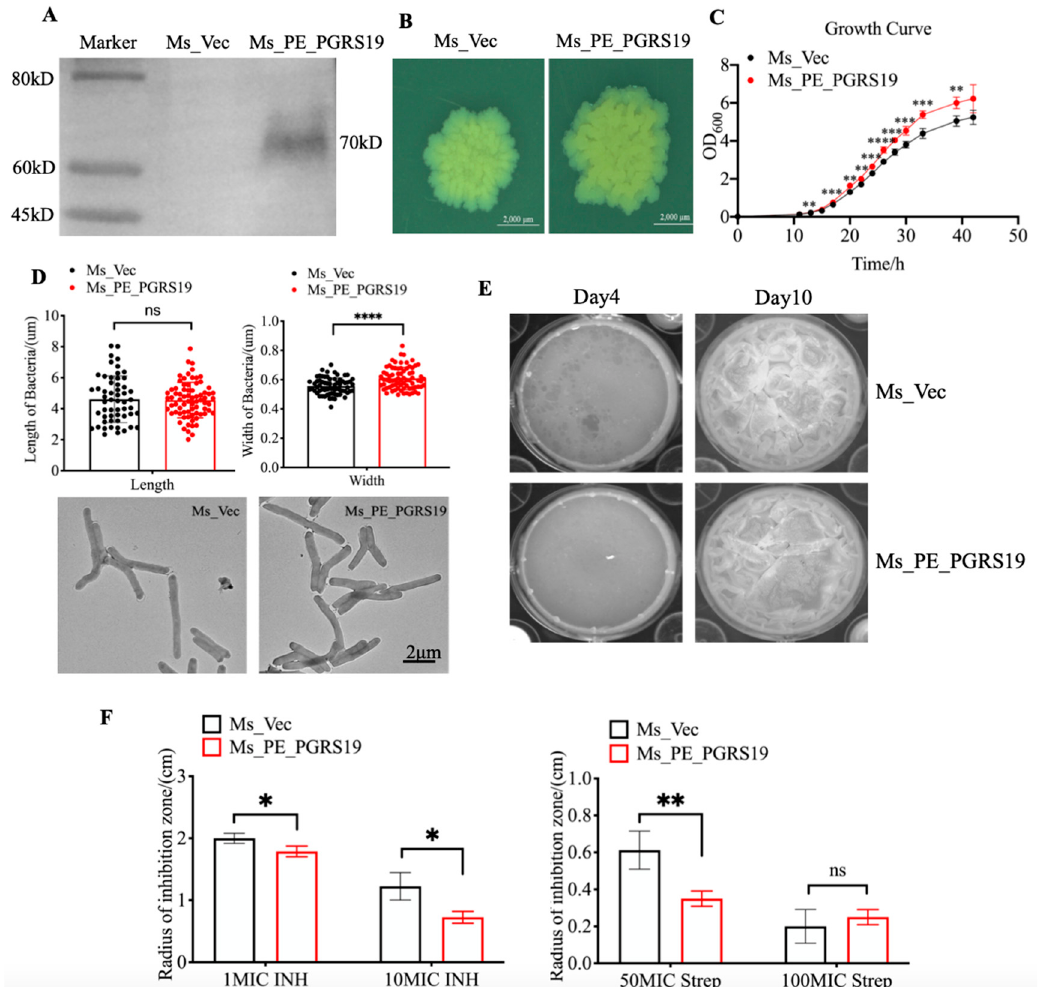
Figure 1. Construction and phenotype characterization of Ms_PE_PGRS19 and Ms_Vec. ( A ) Detection of the recombinant strain by Western blot using a mouse anti-His tag antibody to confirm PE_PGRS19 expression. ( B ) Colony size of Ms_PE_PGRS19 and Ms_Vec after growing on